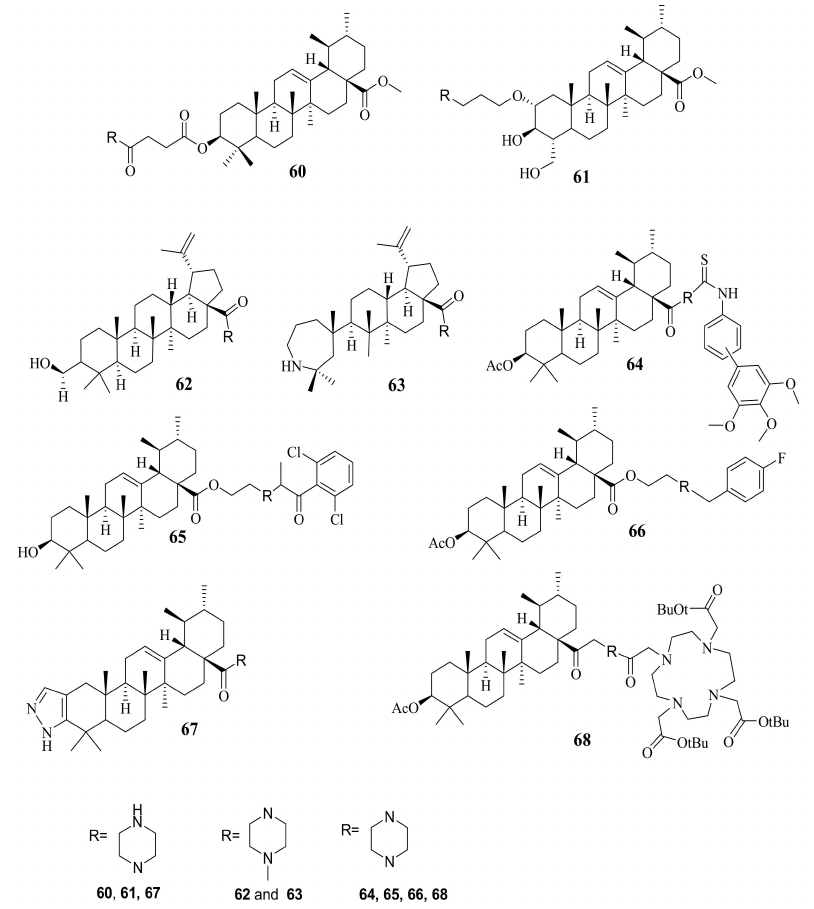
Figure 6. Ursolic acid and betulinic acid-based indole hybrids The ursolic acid derivative 65 with an acyl piperazine moiety at C-28 was synthesized by treating ursolic acid with ethylene dibromide (C 2 H 4 Br 2 ) in Dimethylformamide (DMF) for 24 h. The obtained compound was introduced with piperazine in DMF in the presence of Potassium carbonate (K 2 CO 3 ) at 80 ◦ C, and then reacted with an aromatic to obtain the targeted compound. The newly synthesized compound was evaluated for anticancer activity against human gastric cancer (MGC-803) and breast cancer (Bcap-37) cell lines using standard MTT assay in vitro. The compound showed a cell apoptosis-inducing effect higher than the positive control, HCPT, and UA [102]. Wang et al. [103] designed and synthesized 19 new nitrogen heterocycle-containing ursolic acid derivatives and evaluated their potential antiproliferative activity against the cervical (Hela) and gastric (MKN45) cell lines. The potent anticancer compound was found to be compound 66 (Figure 7, Table 3) with IC 50 values of 2.6 µ M and 2.1 µ M. The study of the mechanism and the in vivo antitumor study of this compound demonstrated reduced apoptosis regulator (Bcl- 2/Bax) ratio, disrupted mitochondrial potential and induced apoptosis, and suppressed the growth of Hela xenografts in nude mice [103]. Li et al. [88] indicated that apoptosis in breast cancer cells was induced by ursolic acid piperazine hybrid derivative (compound 67 (Figure 6)), along with cell cycle arrest induction at S and G0/G1 phase. Thus, compound 67 is a promising therapeutic agent for the treatment of breast cancer. With earlier literature report by Chen et al. [89] suggesting the therapeutic potential of a similar compound against leukemia as summarized in Table 3 [89]. Kahnt et al. [104] prepared 11 conjugates containing piperizine hybrid heterocycles. Amongst all the ursolic acid derivatives, com- pound 68 was most potent with EC 50 values of 1.5 µ M for A375 melanoma and 1.7 µ M for A2780 ovarian carcinoma)